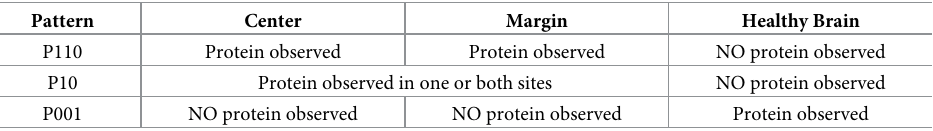
Table 1. Analyzed patterns for protein detection in binary form. Pattern Center Margin Healthy Brain P110 Protein observed Protein observed NO protein observed P10 Protein observed in one or both sites NO protein observed P001 NO protein observed NO protein observed Protein